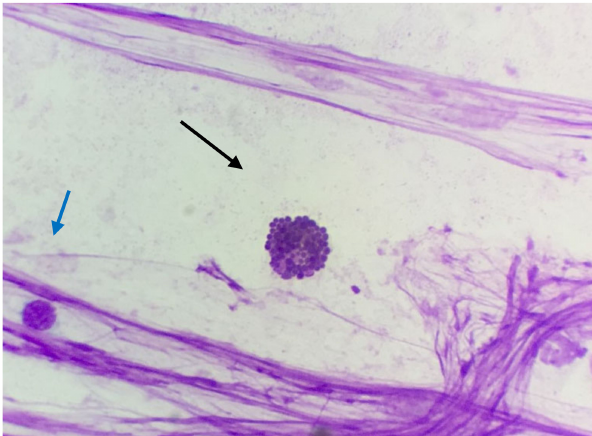
Figure 12. Jenny’s endometrial cytology collected by CB in estrus. Eosinophil (black arrow) and lymphocyte (blue arrow). Proteinaceous background, Modified Wright’s stain 1000 ×